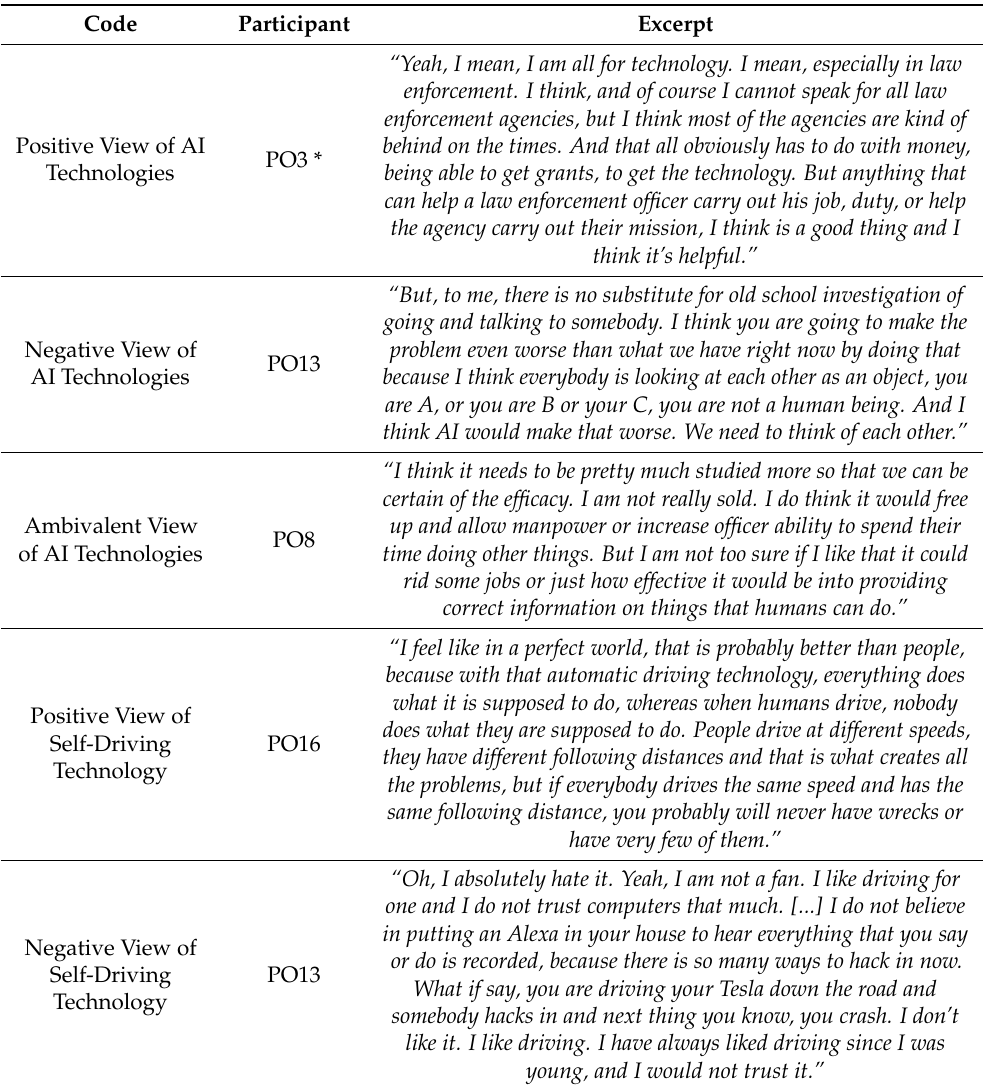
Table 2. Excerpts on the Views of Artificial Intelligence Technologies and Self-Driving